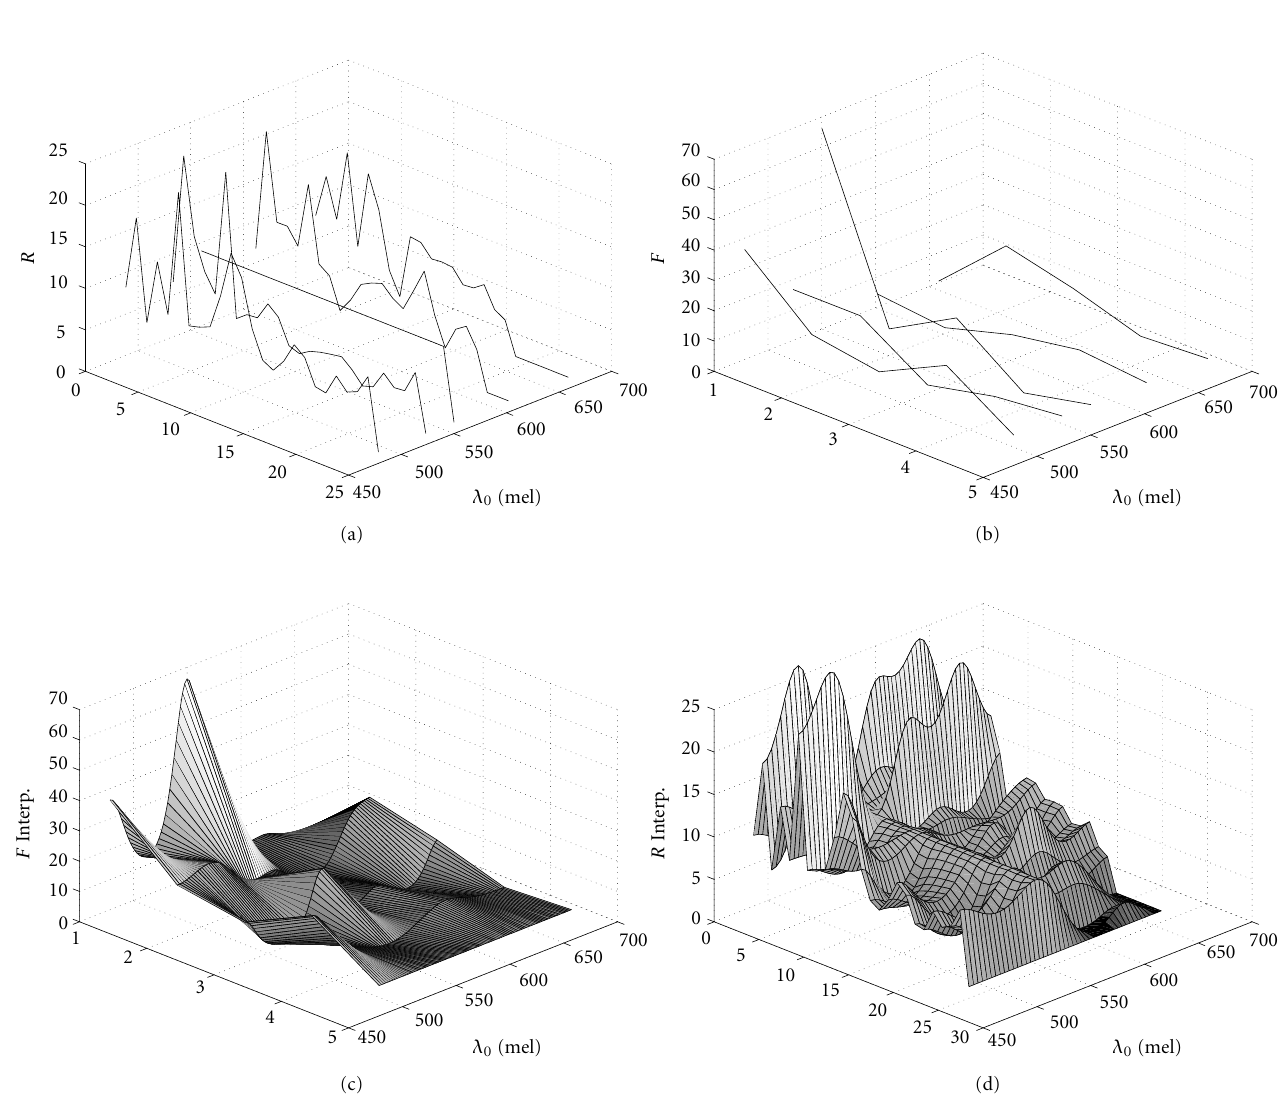
Figure 7: Reduction of the parametric model. The example is relative to a conversion function for pitch control, and the training data is made of five violin notes. Here, (a) is the original conversion patterns matrix R , (b) is the matrix F with P = N = 5 , (c) is the interpolating surface for the matrix F and (d) is (c) after multiplication by the principal components matrix # V